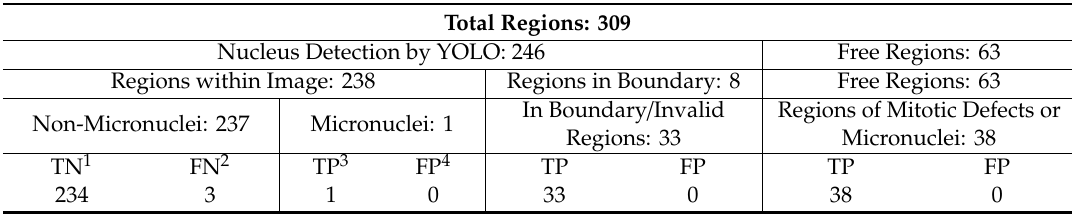
Figure 17. Experiment 2 on the HT29 cell image obtained from the web site of CellProfiler [41]: ( a ) the normal nuclei are distinguished from abnormal nuclei with rectangular boxes; ( b ) histogram of normal nuclei (non-micronuclei) and abnormal nuclei (micronuclei/mitotic defects). Table 2. The number of cell nuclei (experiment 2).